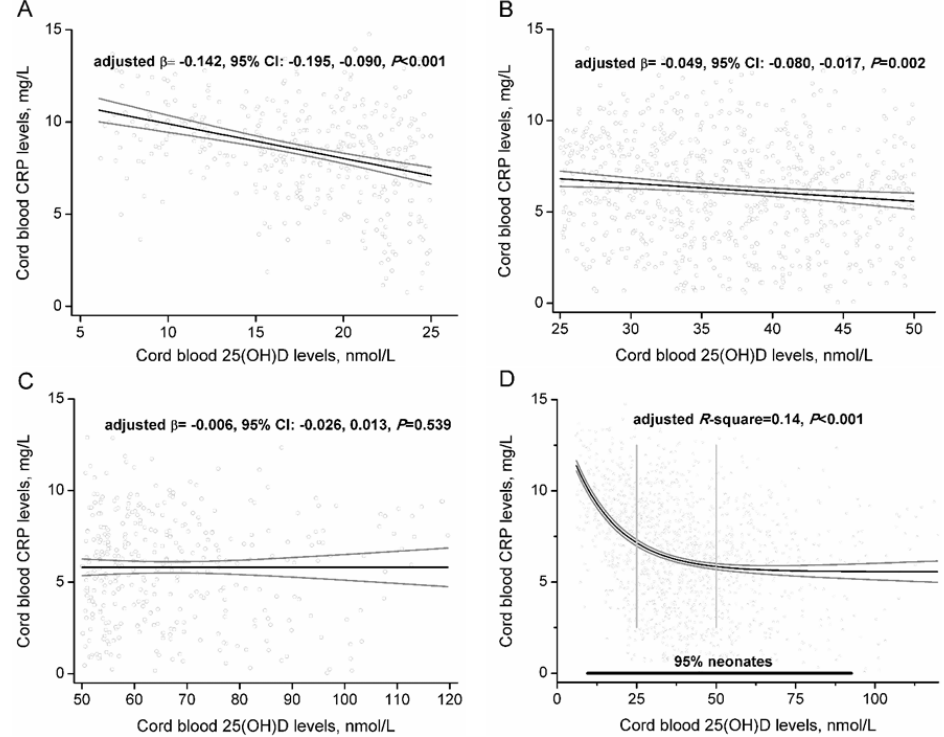
Figure 2. Association between cord blood 25(OH)D and CRP levels, stratified by 25(OH)D levels. Multiple linear models were conducted to assessed the adjusted regression coefficient among neonates with 25(OH)D less than 25.0 nmol/L ( A , n = 389), between 25.0 nmol/L and 49.9 nmol/L ( B , n = 731) and more than 50.0 nmol/L ( C , n = 371), respectively. Potential confounders included maternal sociodemographic characteristics, perinatal health status, lifestyle, and birth outcomes. A nonlinear regression model with sine function was conducted to fit the nonlinear relation between 25(OH)D and CRP among all neonates ( D , n = 1491). The solid black line denotes the fit of the regression model, the solid grey line denote 95% CI. The vertical lines denote 25(OH)D benchmarks.